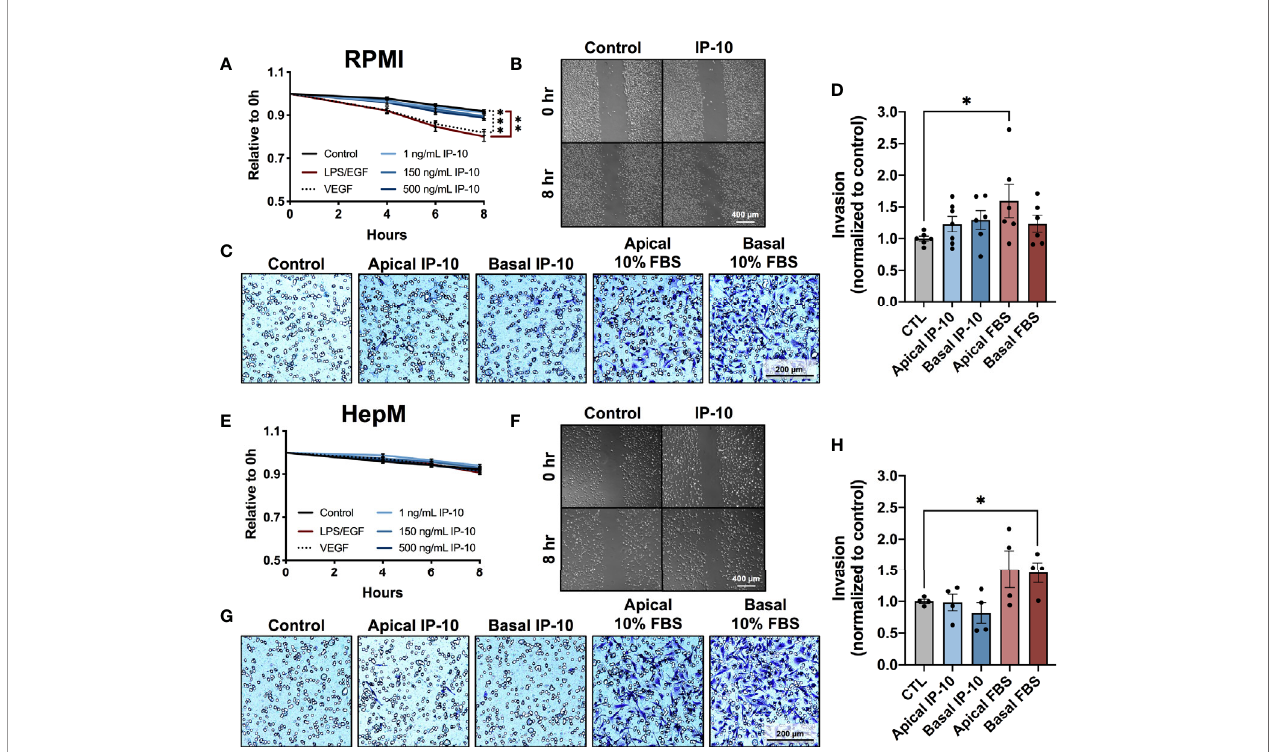
FIGURE 4 | The migratory and invasive properties of breast cancer cells are not directly affected by IP-10. MDA-MB-231 cells cultured in either (A – D) RPMI or (E – G) HepM medium. (A, E) Scratch migration assay measured over 8 hours (mean ± SEM; Two-way ANOVA with Dunnett ’ s multiple comparisons test, ** p < 0.01, *** p < 0.001; n = 3). (B, F) Representative images of the scratch migration assay at 8 hours. (C, G) Representative images of the invasion assay at 48 hours. (D, H) Quanti fi cation of invading cells (mean ± SEM; Student t-test, * p < 0.05;